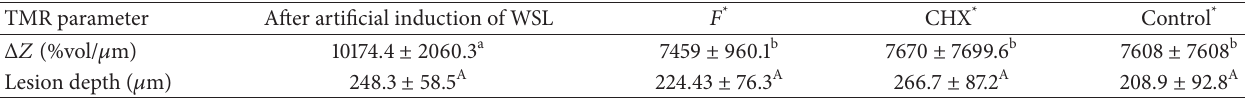
Table 3: Summary and statistical comparison for TMR parameters after WSL induction and 3 months after the last application of 𝐹 or CHX (mean ± SD).